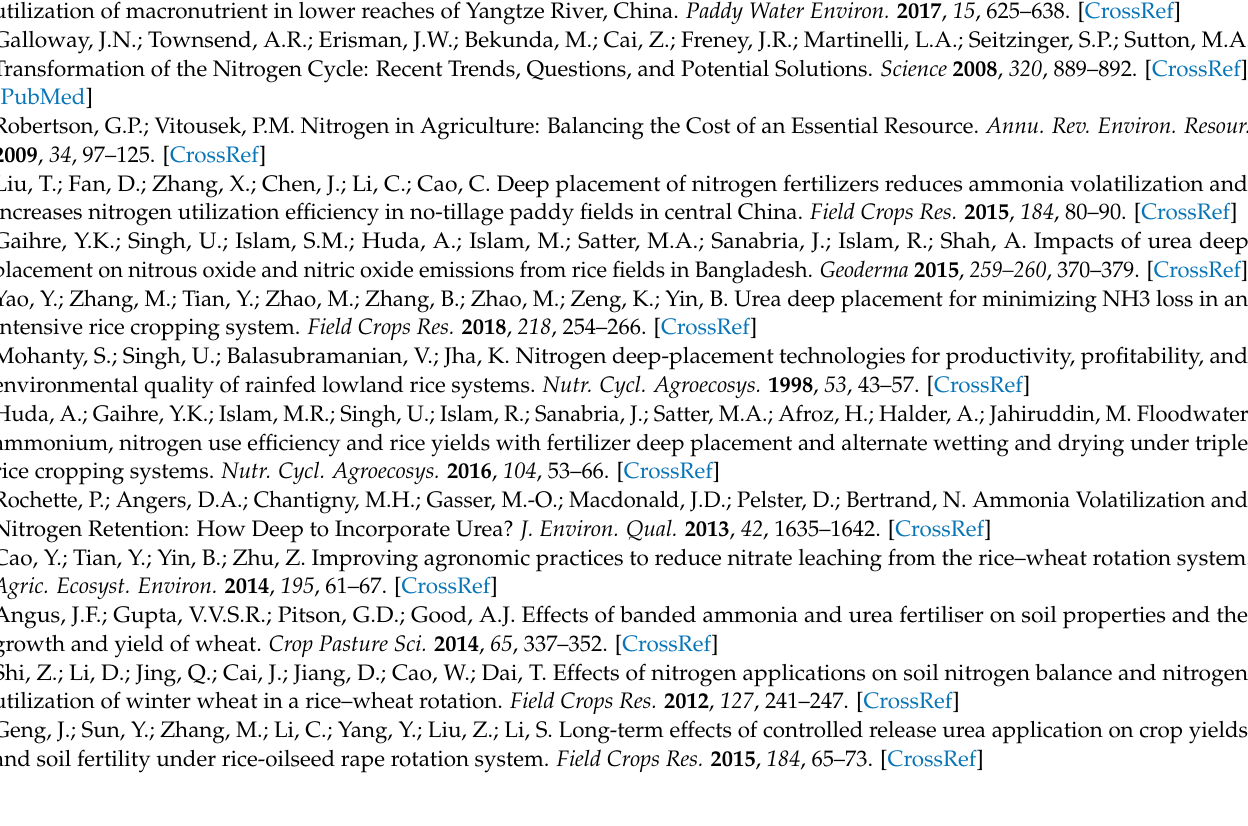
Table S3: The Spearman’s correlations (r) between soil properties and dominated bacteria phyla at different incubation times for Qidong (QD) soil. Table S4: The Spearman’s correlations (r) between soil properties and dominated bacteria phyla at different incubation times for Dangtu (DT) soil. Table S5: The Spearman’s correlations (r) between soil properties and α -diversity indices at different incubation